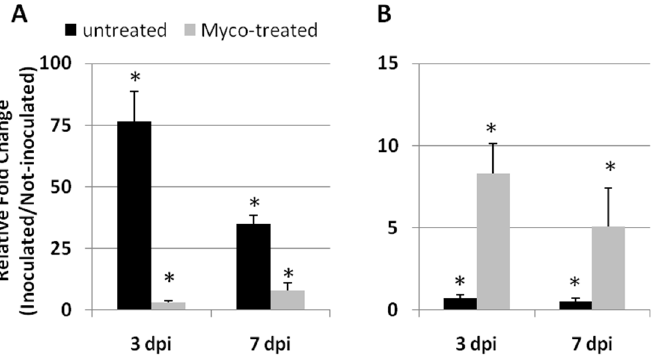
Figure 7. Expression of GPX ( A ) and PR-4b ( B ) genes in tomato roots of untreated and Myco-treated plants by quantitative real-time reverse-transcription polymerase chain reaction (qRT-PCR). Relative fold changes (the value 1 indicates no change) of nematode inoculated with respect to not inoculated plants were detected at 3 and 7 days post-inoculation (dpi). Data are the mean fold changes ( n = 6) ± SD in gene transcript levels. An asterisk (*) indicates that the mean fold change is significantly different from 1 as determined by the non-parametric Kolmogorov–Smirnov test ( p < 0.05).